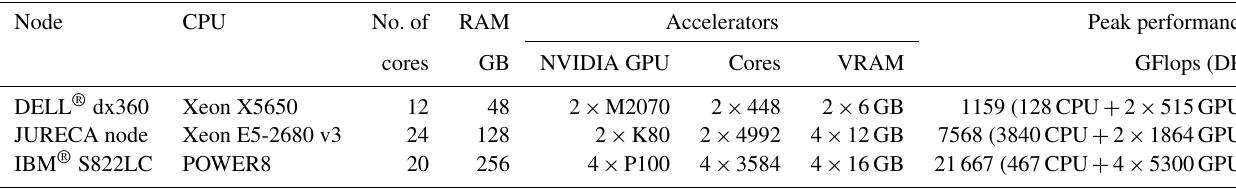
Table 2. Experimental configuration of the simulation. Number of columns 8192 columns with 90 levels Number of grid